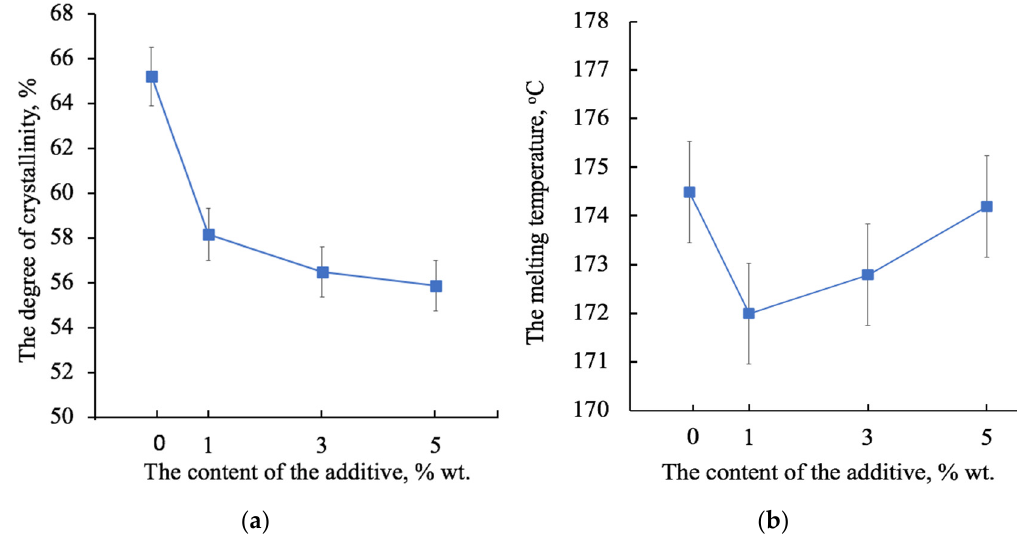
Figure 6. The changes in the degree of crystallinity ( a ) and the melting temperature ( b ) of the PHB depending on the concentration of the hemin from the first heating.